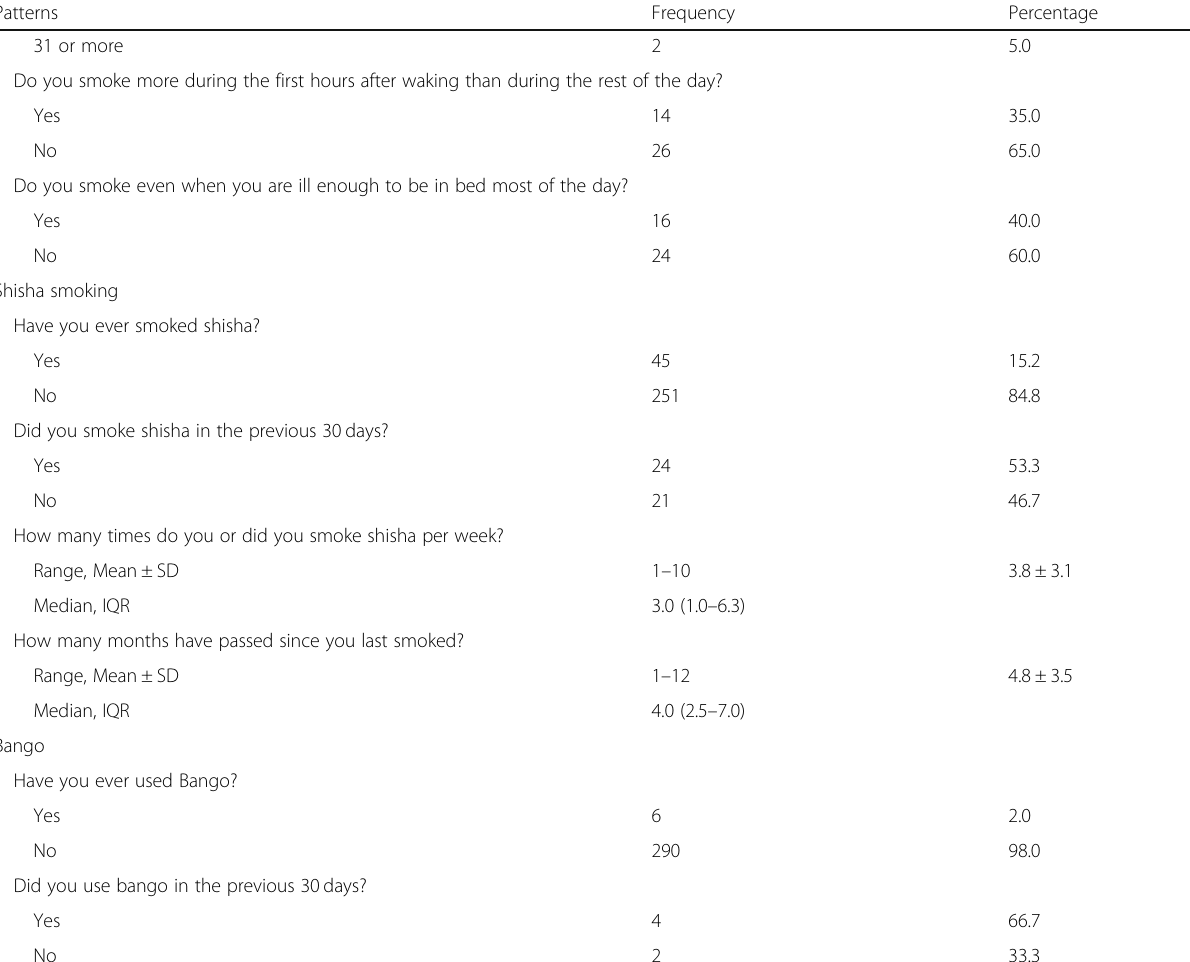
Table 4 Patterns and frequency of smoking and bango use among students, Cairo University, academic year 2014 – 2015 (Continued)